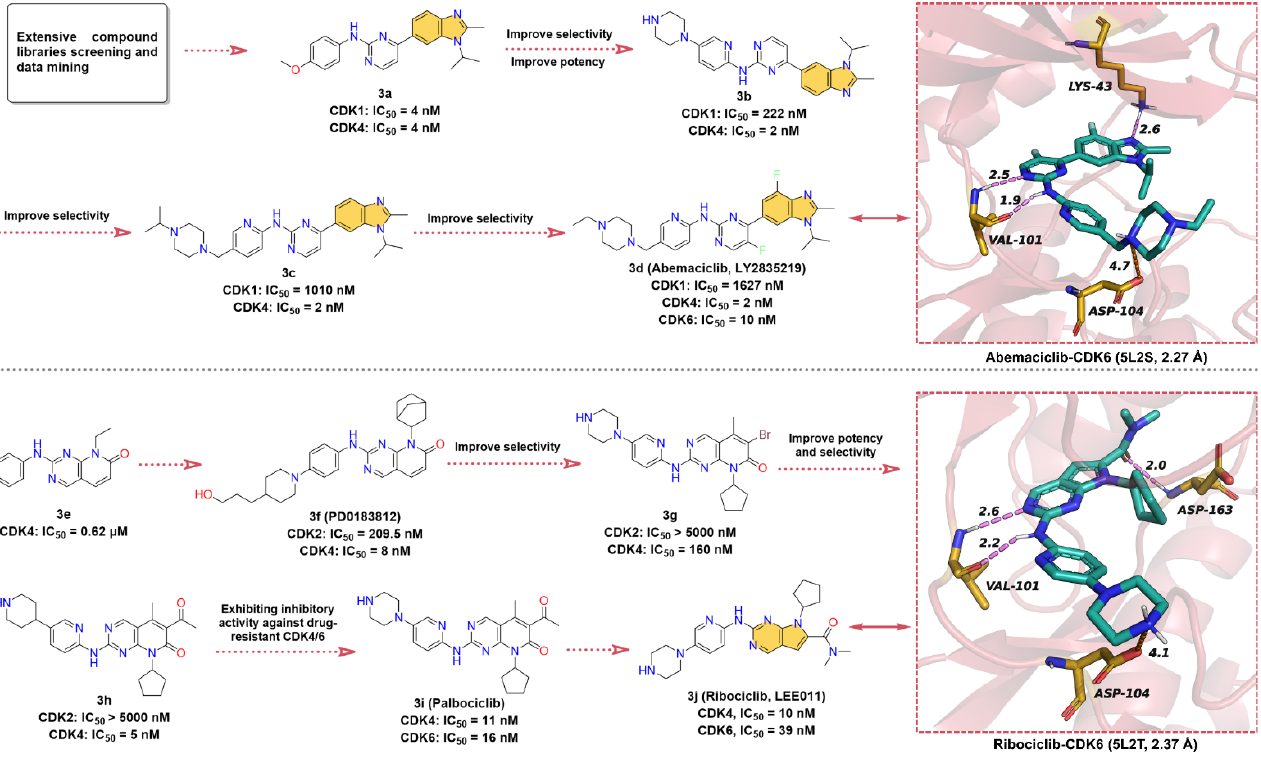
Figure 3. Key medicinal chemistry optimization of Abemaciclib and Ribociclib along with the binding model with CDK6.